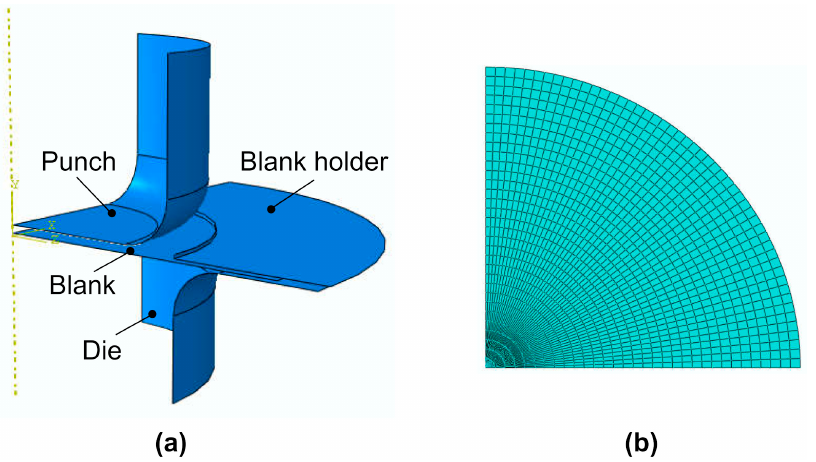
Figure 4. Finite element simulation of the deep drawing process: ( a ) a quarter finite element (FE) model and ( b ) FE mesh of blank sheet. Table 1. Geometric dimensions for the circular cup deep drawing process (mm) [36].